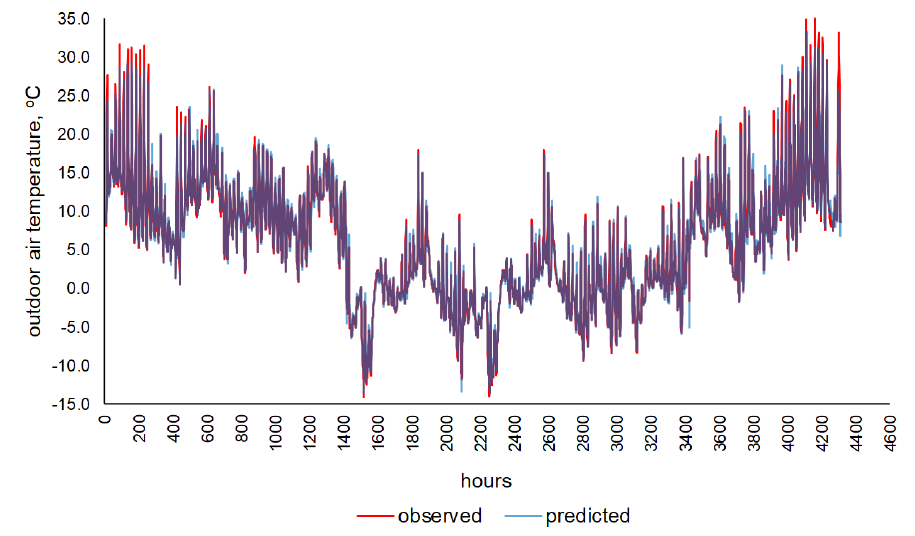
Figure 2. The course of observed and predicted outdoor air-temperature time series.